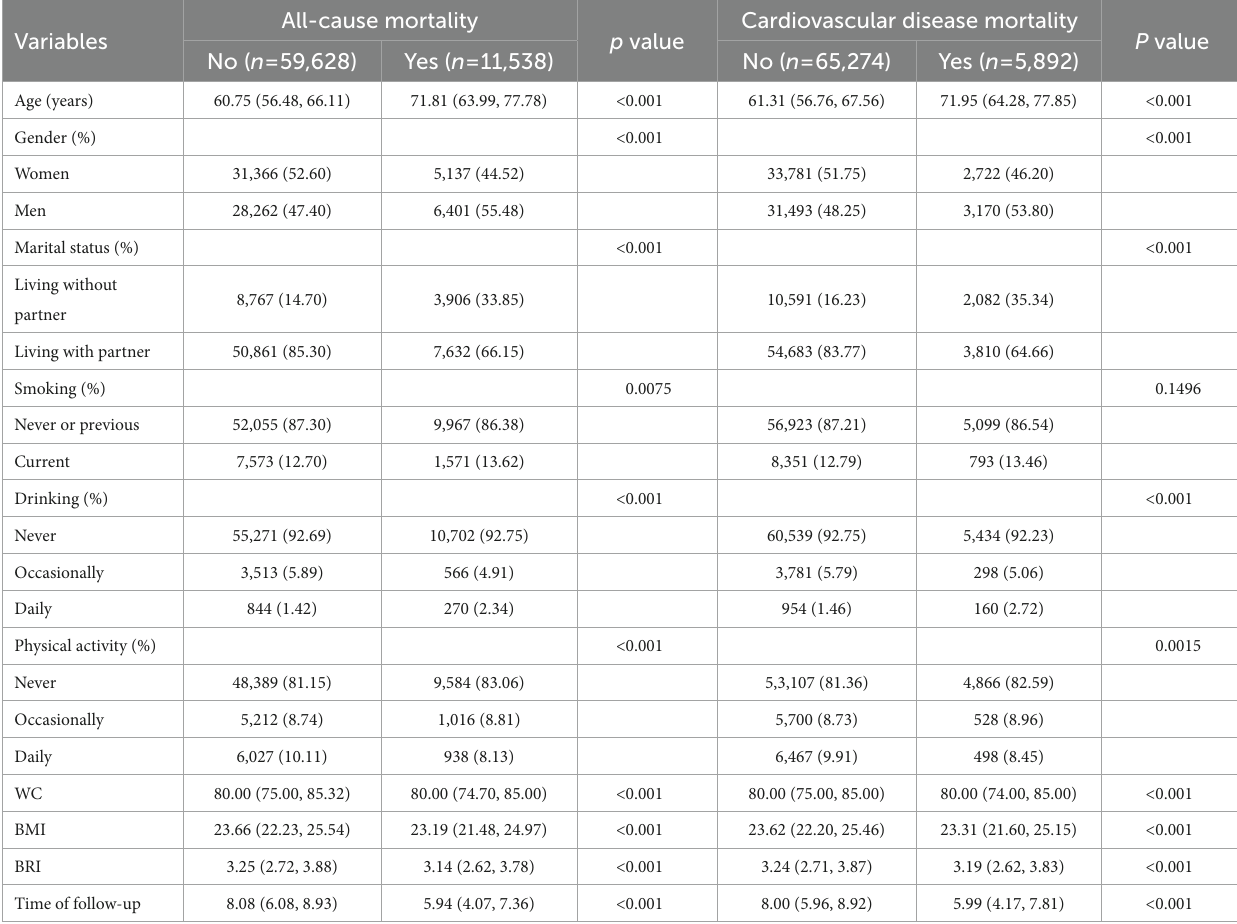
TABLE 1 Baseline characteristics of the study population stratified by outcome.